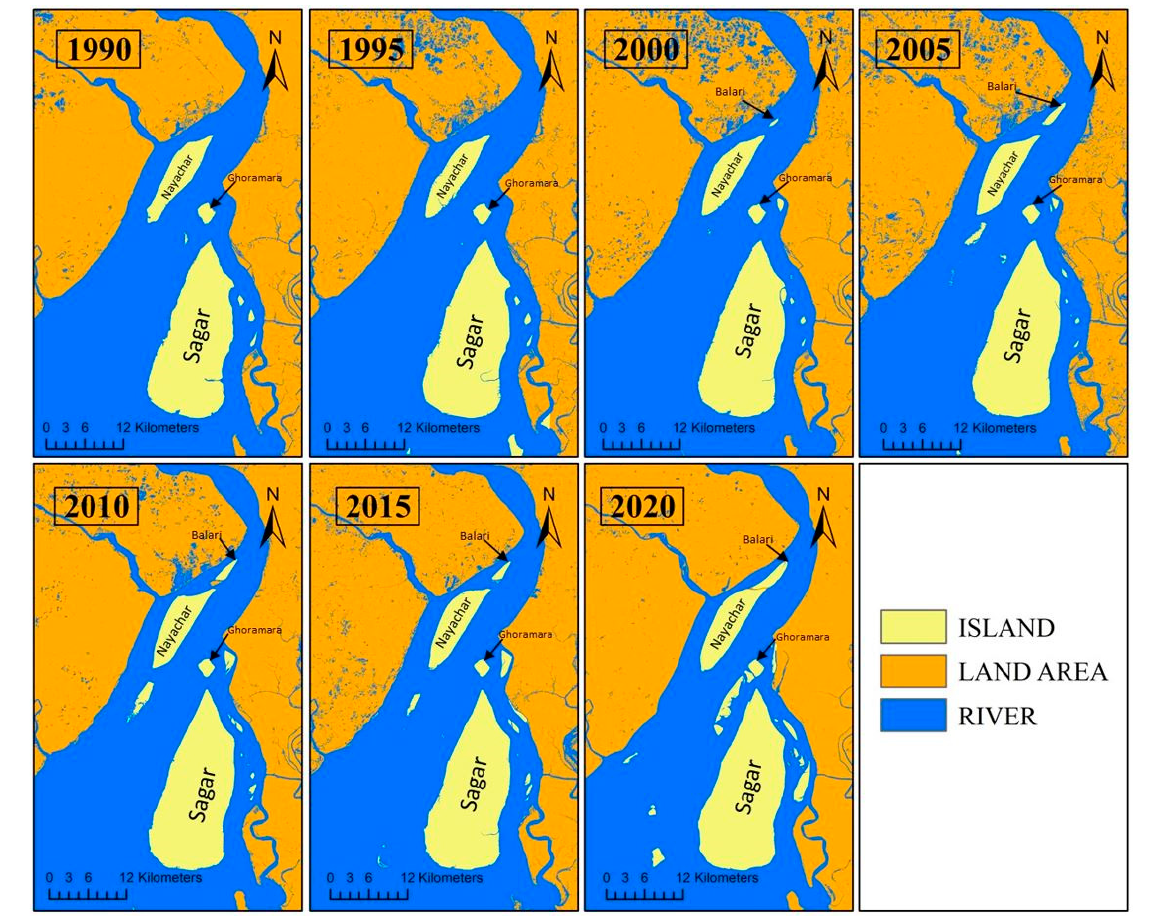
Figure 8. Sedimentation scenarios across the Hugli estuarine islands.